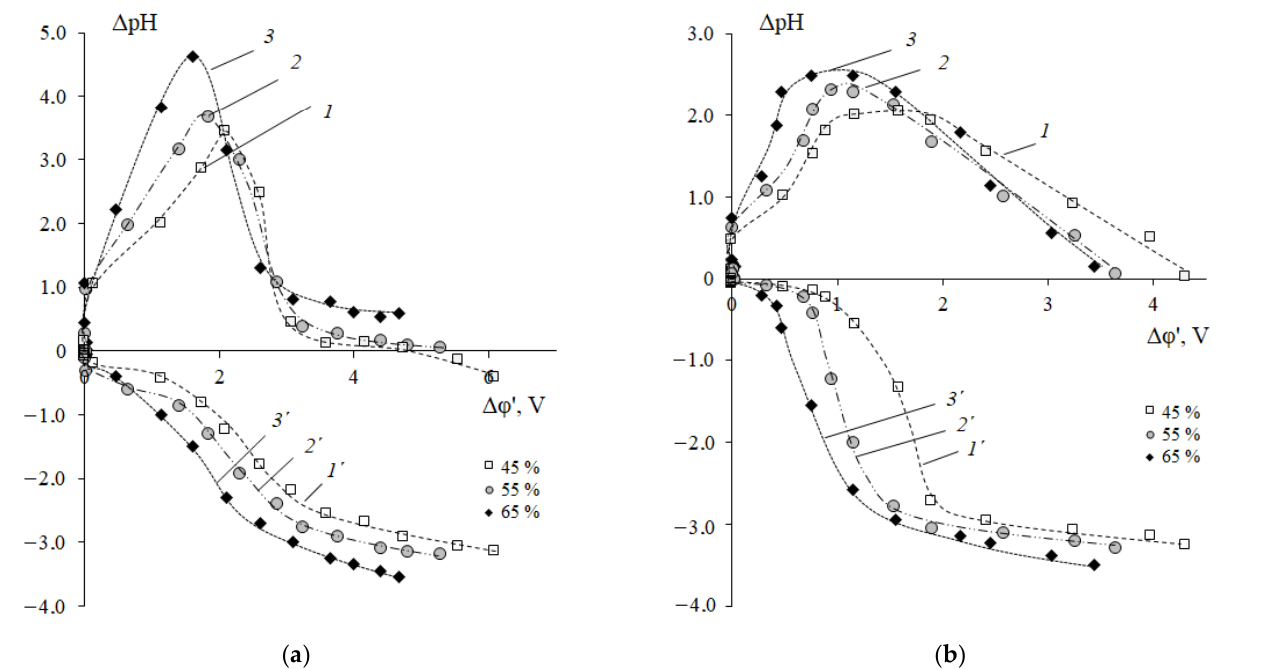
Figure 7. Dependences of the ΔpH of the solution at the outlet and inlet of the demineralization (curves 1 – 3) and concentrate (curves 1´ – 3´) compartments on the corrected potential drop Δφ ´ during electrodialysis of 0.01 M NaCl solution ( a ) and the mixed 0.01 M NaCl + 0.05 M Phe solution ( b ). Cation-exchange membranes with the resin content of 45 ( 1 , 1´ ), 55 ( 2 , 2´ ) and 65 ( 3 , 3´ ) wt%.